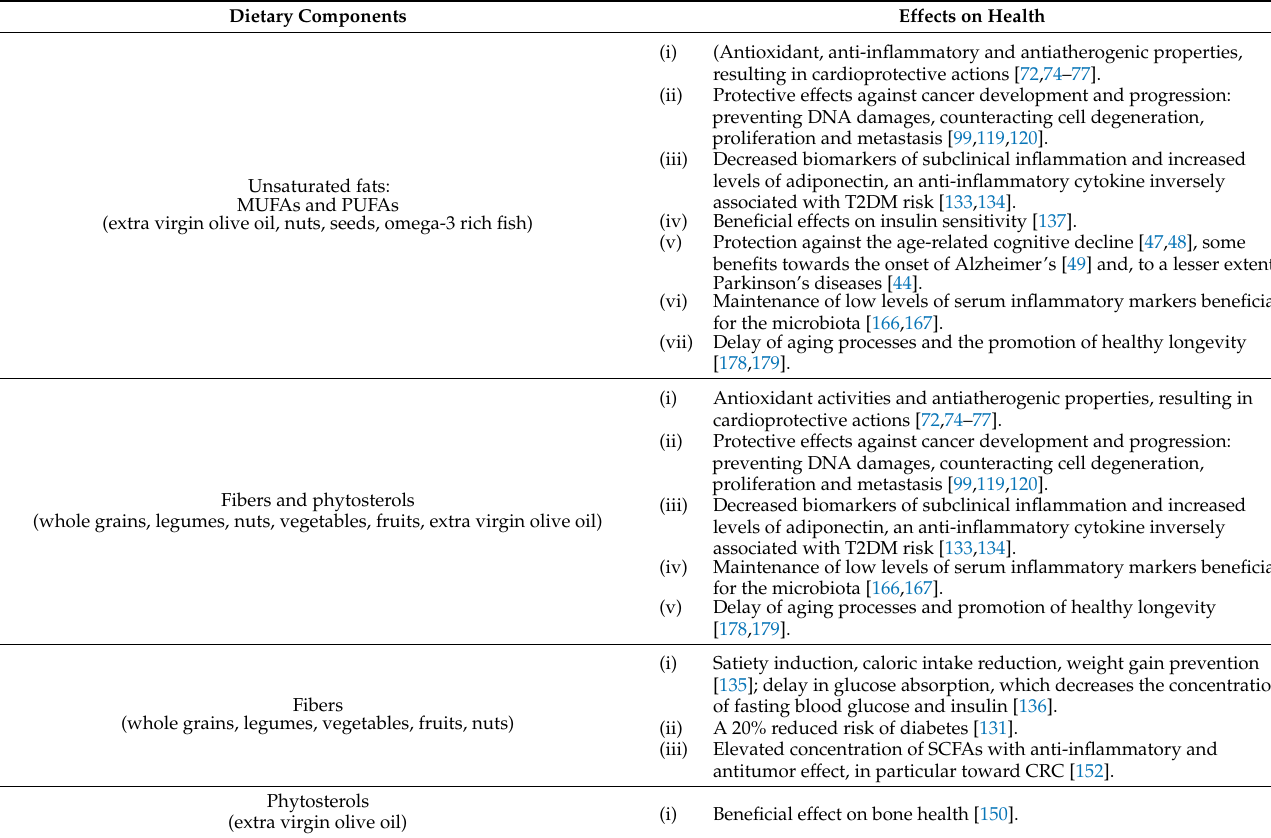
Table 3. Major Mediterranean-type dietary components and their effects on health.